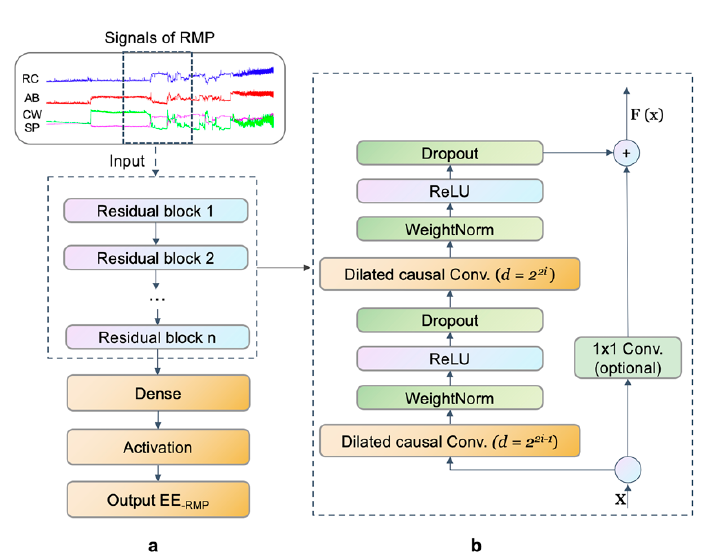
Figure 5. Architecture of the temporal convolutional network model. ( a ) Process, ( b ) an example of the residual block. EE -RMP : Energy expenditure measured from respiratory magnetometer plethys- mography. Signals of RMP including four distances: RC, AB, CW, and SP. RC: rib cage; AB: abdomen; CW: chest wall; SP: spine.